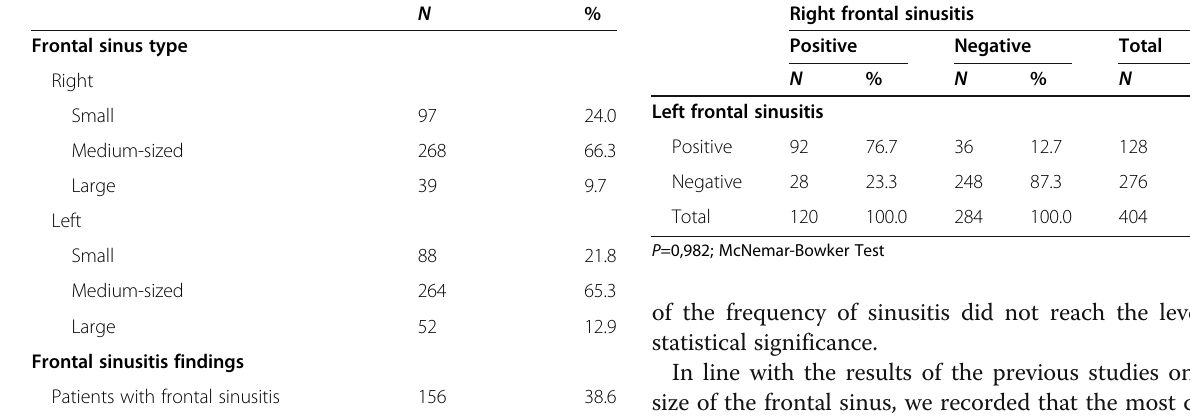
Table 1 The findings recorded in terms of sinusitis and sinus type in 808 frontal sinuses of 404 patients in the study group